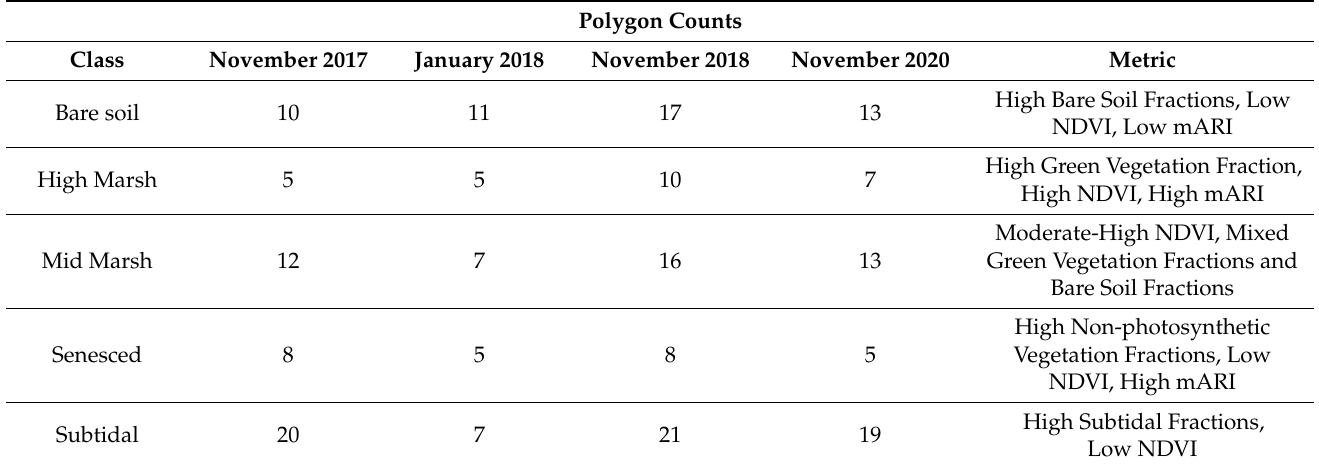
Table 2. Polygon counts and decision metrics for training data